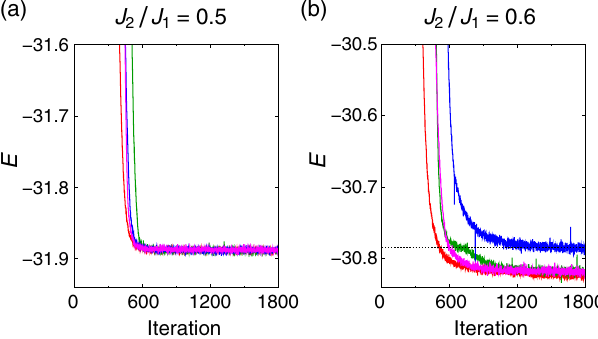
FIG. 12. Initial-parameter dependence of the RBM þ PP opti- mization curves for the ground state at (a) J 2 ¼ 0 . 5 and (b) J 2 ¼ 0 . 6 for the 8 × 8 lattice. The results for the four independent optimizations are shown for each J 2 . In (b), the dotted line indicates the total energy of a local-minimum